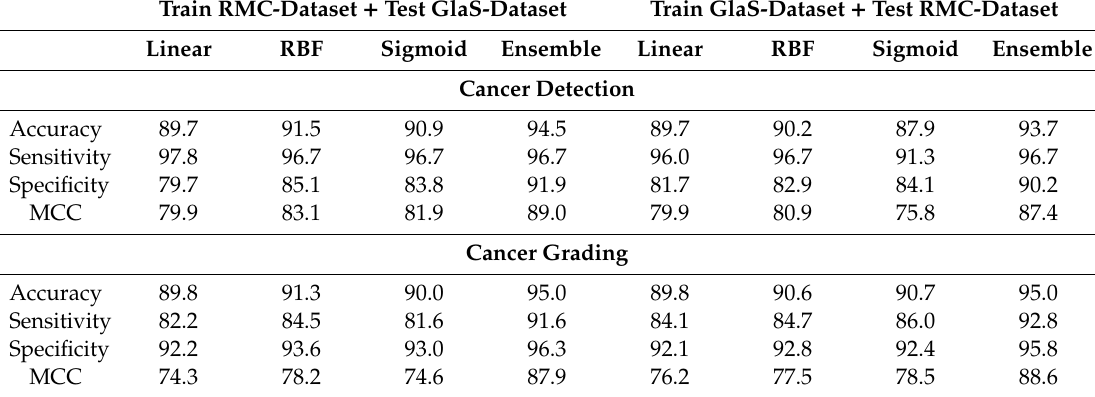
Table 4. Performance of the meta-classifier across multi-institutions (results are shown for individual and ensemble classifiers).